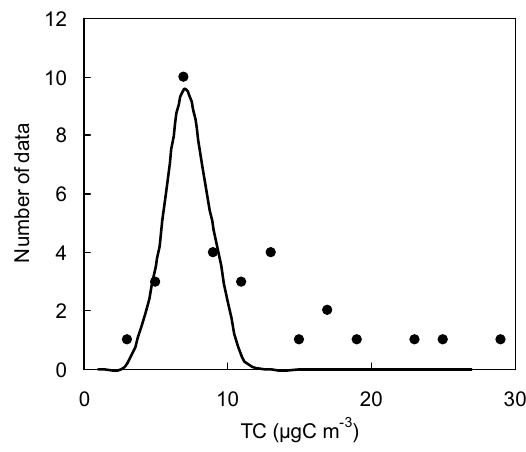
Fig. 2. Frequency distribution of TC mass concentrations during the entire sampling period. Number of data in each bin was cal- culated with 2µgCm − 3 increment. Gaussian fit of the frequency distribution showed a peak center at 7.2µgCm − 3 with the width of 3.1µgCm − 3